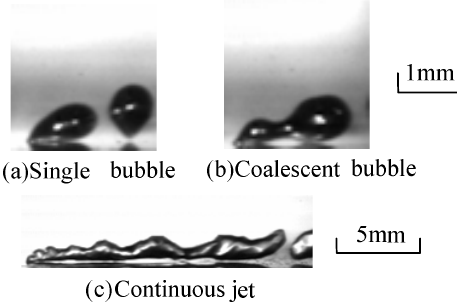
Fig.3 Flow patterns of the jet from the